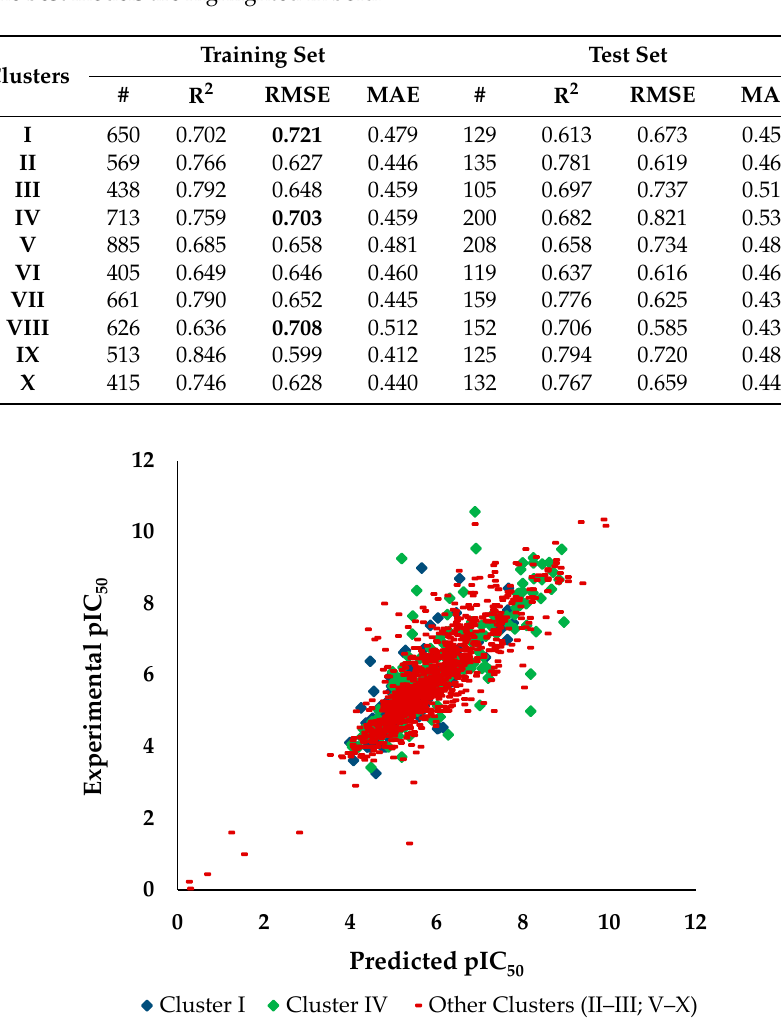
Table 5. The predictions of the best HCT116 QSAR model by the ten structural clusters for training and test sets. The best models are highlighted in bold.